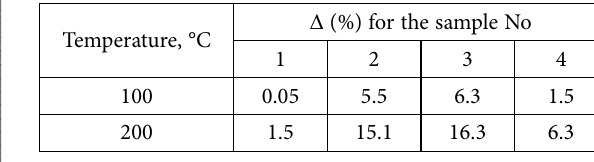
Table 3. Mass reduction of samples, %